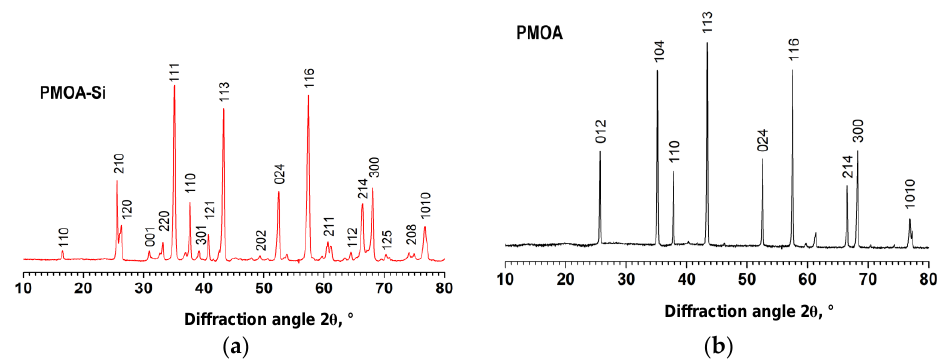
Figure 3. XRD patterns of the samples after isochronous 4 h annealing at fixed temperatures: ( a ) PMOA and ( b ) PMOA-M.